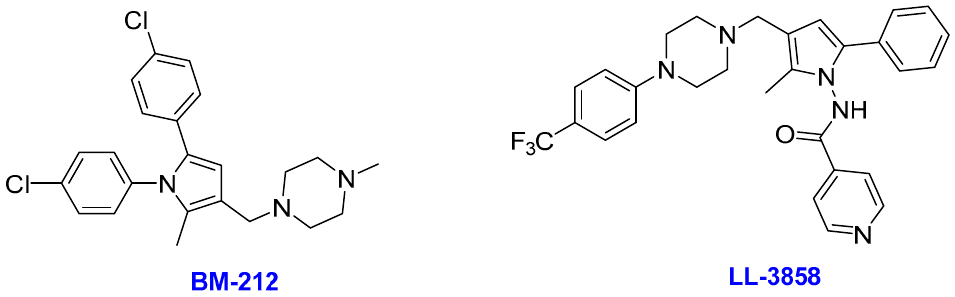
Figure 10. The chemical structures of pyrrole drug candidates being investigated for TB treatment.